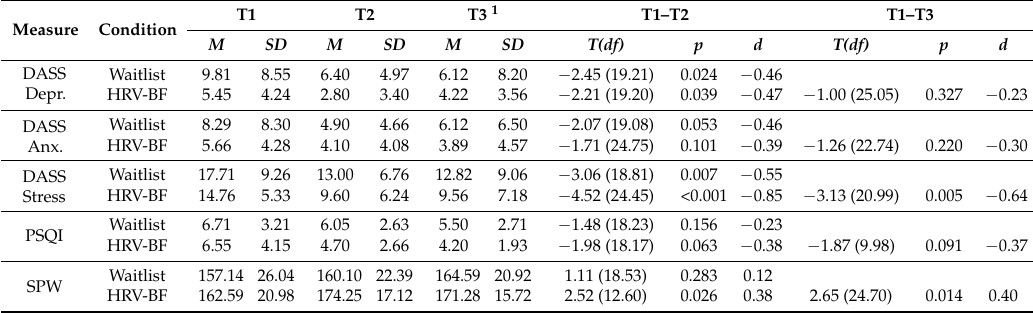
Table 2. Observed means and Cohen’s d within-group effect sizes for stress and stress-related symptoms per